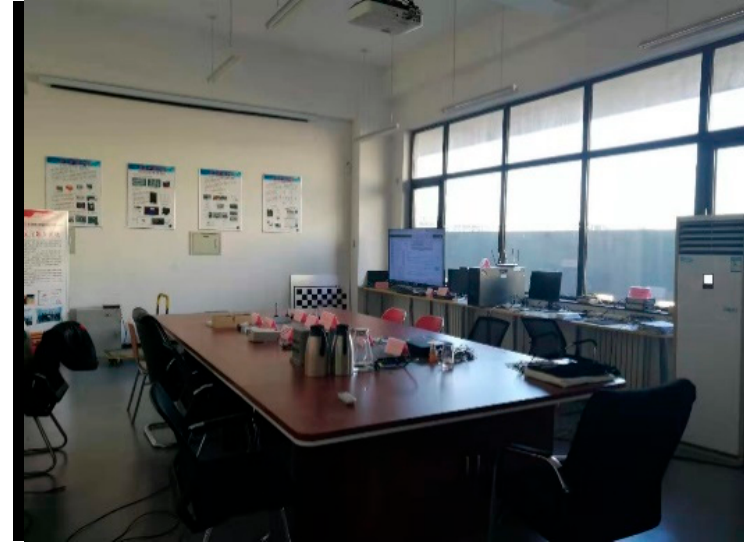
Figure 5. The test environment of experiment 1.